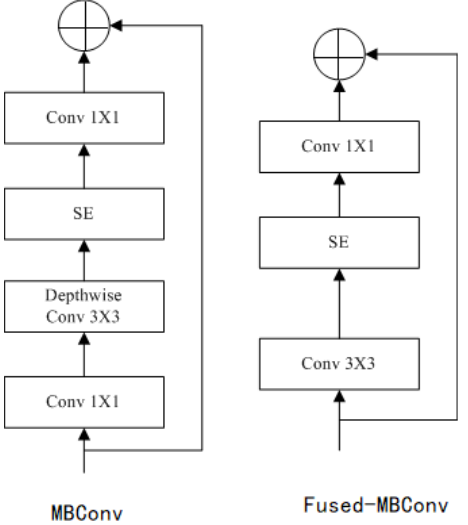
Figure 6. Schematic diagram of the improvement of EfficientNetv2 structure.